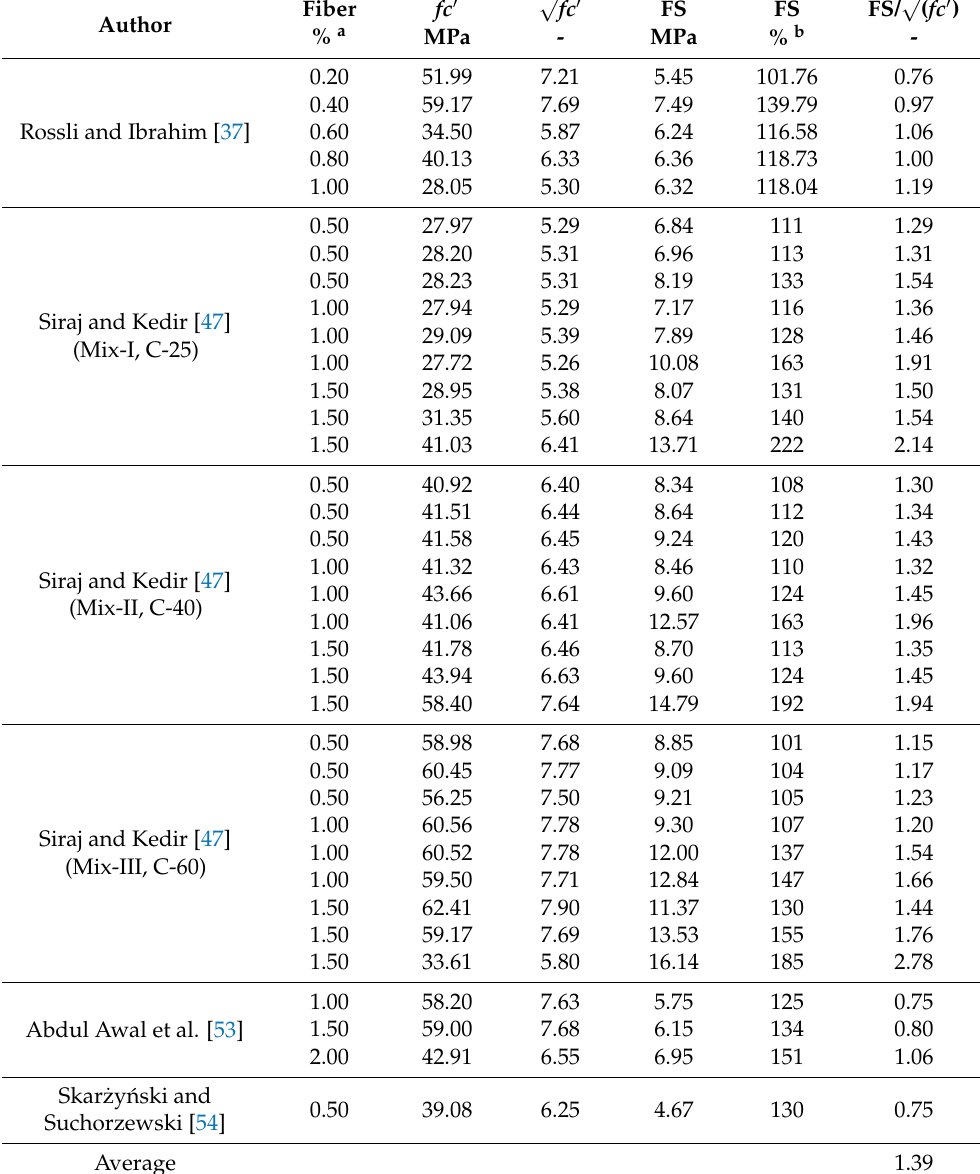
Table 15. The ratio between compressive strength and flexure strength for RSF